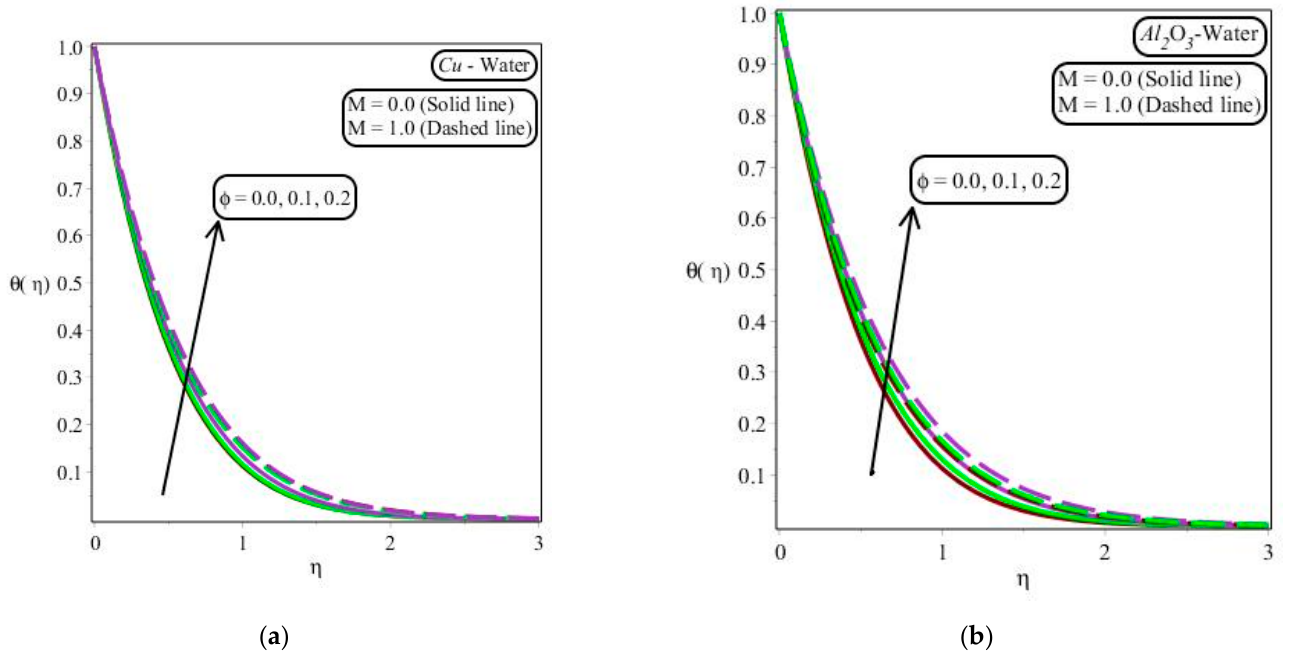
Figure 4. ( a , b ) Impact of β on velocity profile with γ = π /3, K 1 = 0.7, and M = 0.2.